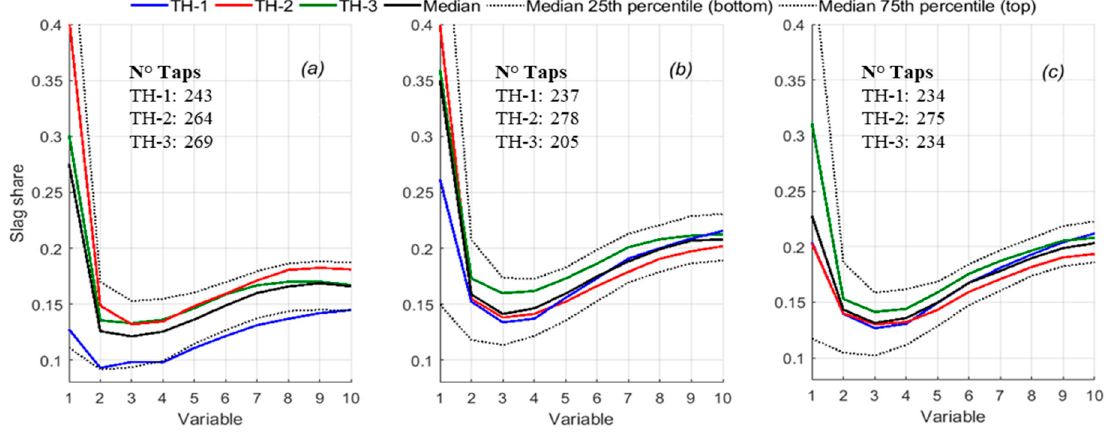
Figure 4. Overall median curves of Data set 1 and 2 and median by taphole (TH), ( a ) Data set 1, ( b ) first half of Data set 2, ( c ) second half of Data set 2.